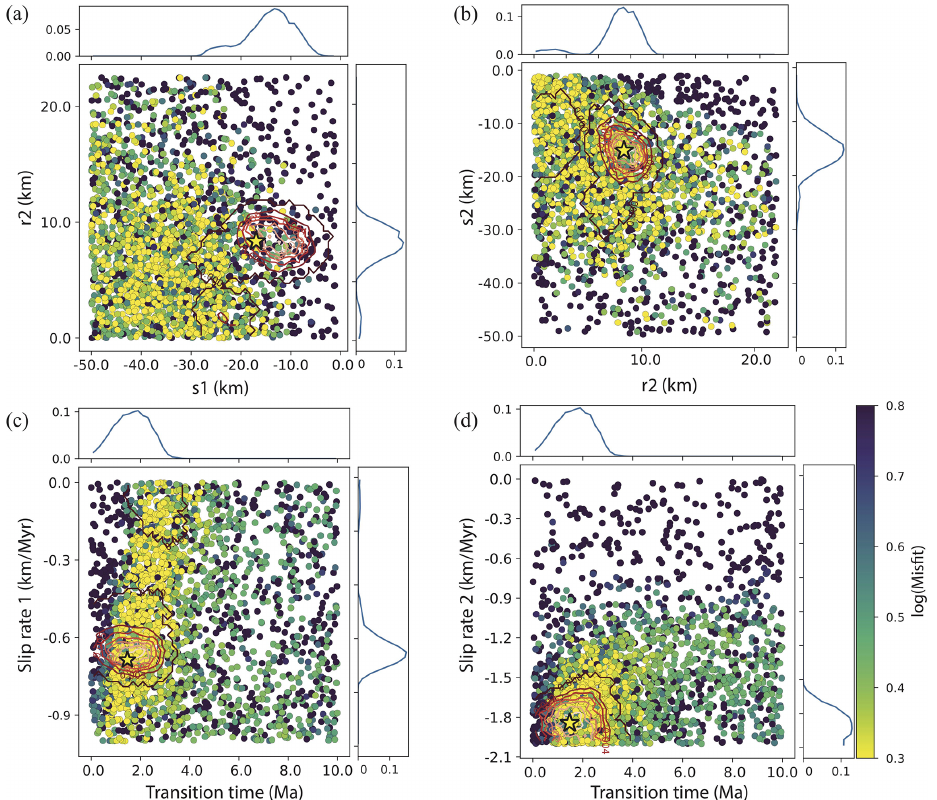
Figure 6. Scatterplots of PECUBE inversion results for two-segment thrust scenario model of the Kawagebo massif. Coloured dots represent single forward-model runs plotted in two-dimensional projections of the parameter space, with colours corresponding to misfit values, shown on a log scale. Posterior probability density functions for parameter values are plotted along the axes. The best-fit solution is represented by a star with 2 σ (dark red) and 1 σ (light red) confidence contours. (a) Depth of the base of the flat ( s 1 ) versus the horizontal location of the base of the ramp, relative to the surface trace of the thrust ( r 2 ). (b) The horizontal distance of the base of the ramp ( r 2 ) versus the depth of the base of the ramp ( s 2 ). For explanation of these parameters, see Fig. 5c. (c) Transition time versus slip rate along the fault during the first phase. (d) Transition time versus slip rate along the fault during the second